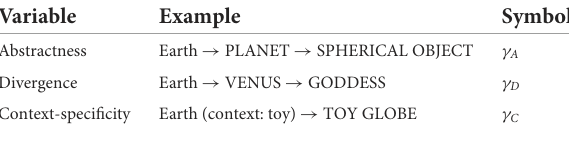
TABLE 1 Examples of the three dimensions modeled in this paper that moderate how one thought leads to the